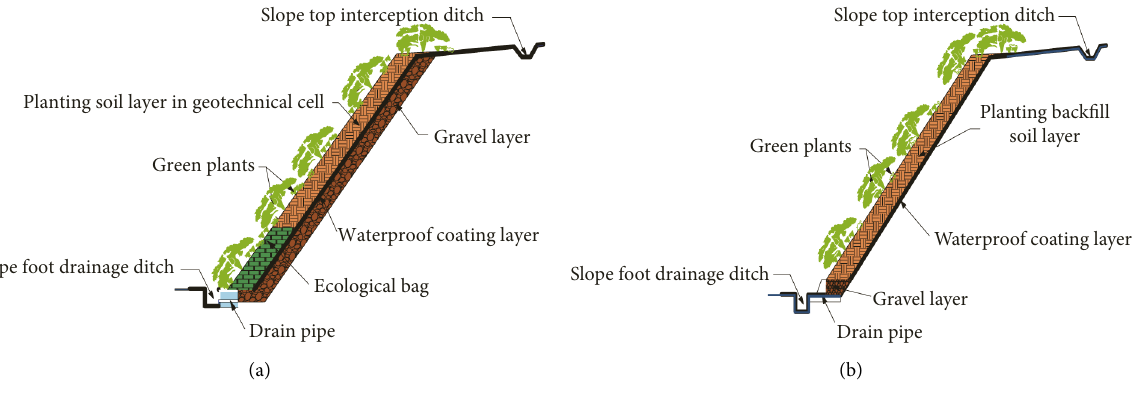
Figure 18: New research schemes. (a) Scheme I; (b) Scheme II.